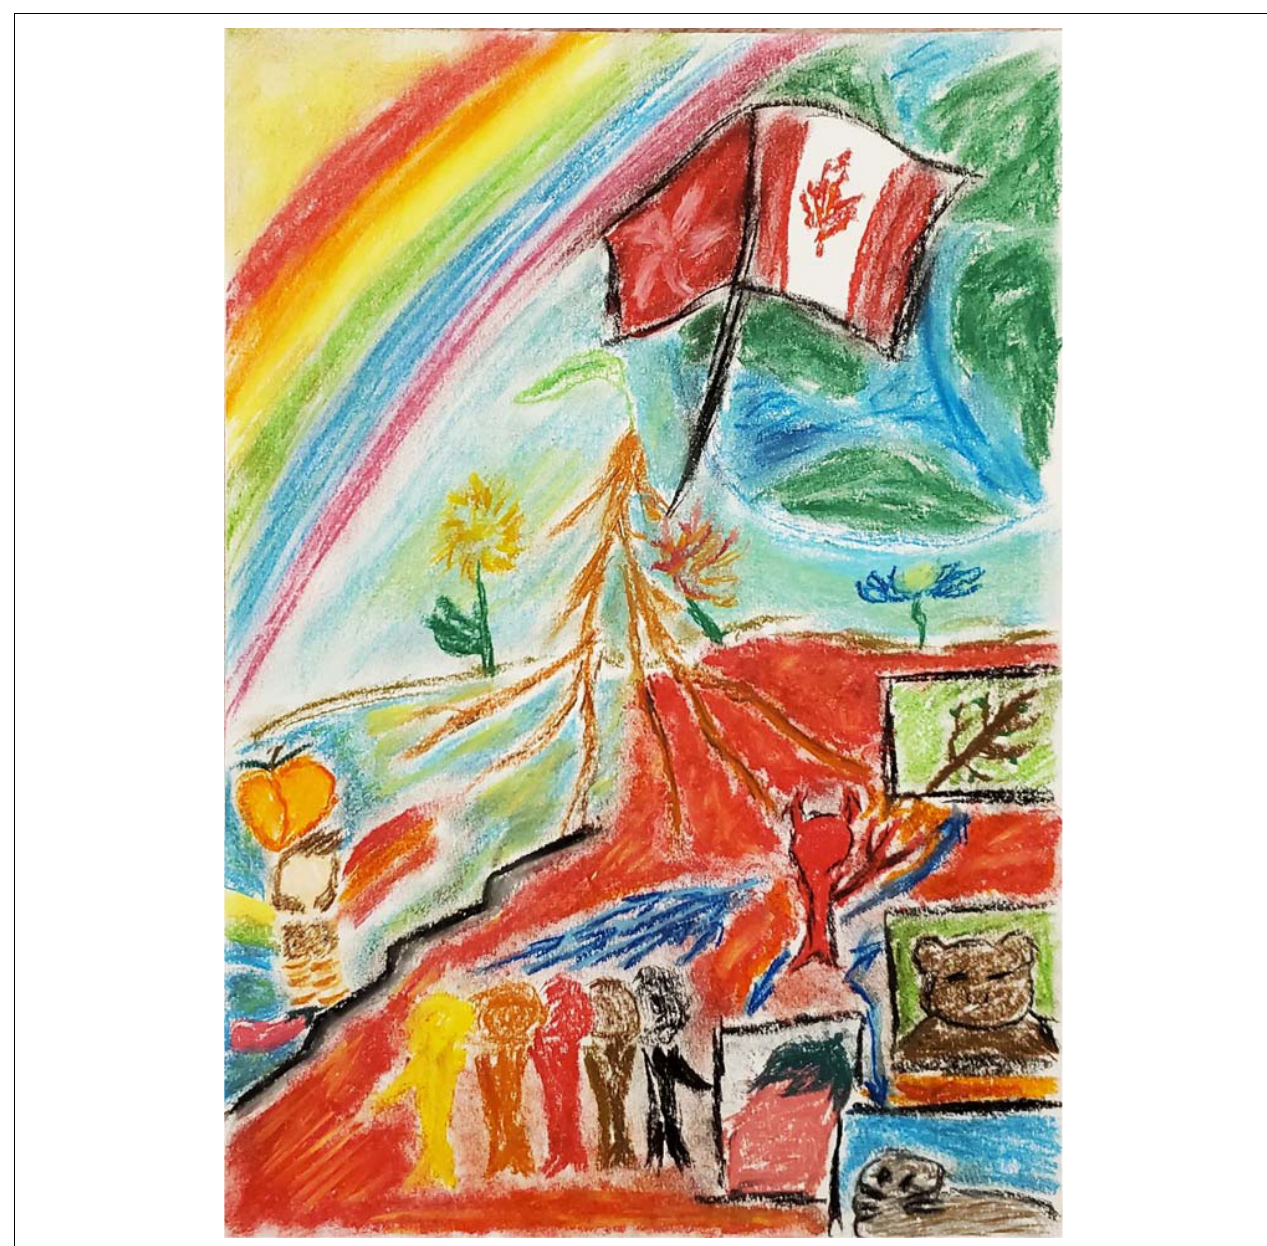
FIGURE 1 | Abstract interpretation of LGBTQ+ research and intersectionality. Above the ground depicts a positive outlook to LGBTQ and ethnic minority representation. Underground depicts the division and categorization between the